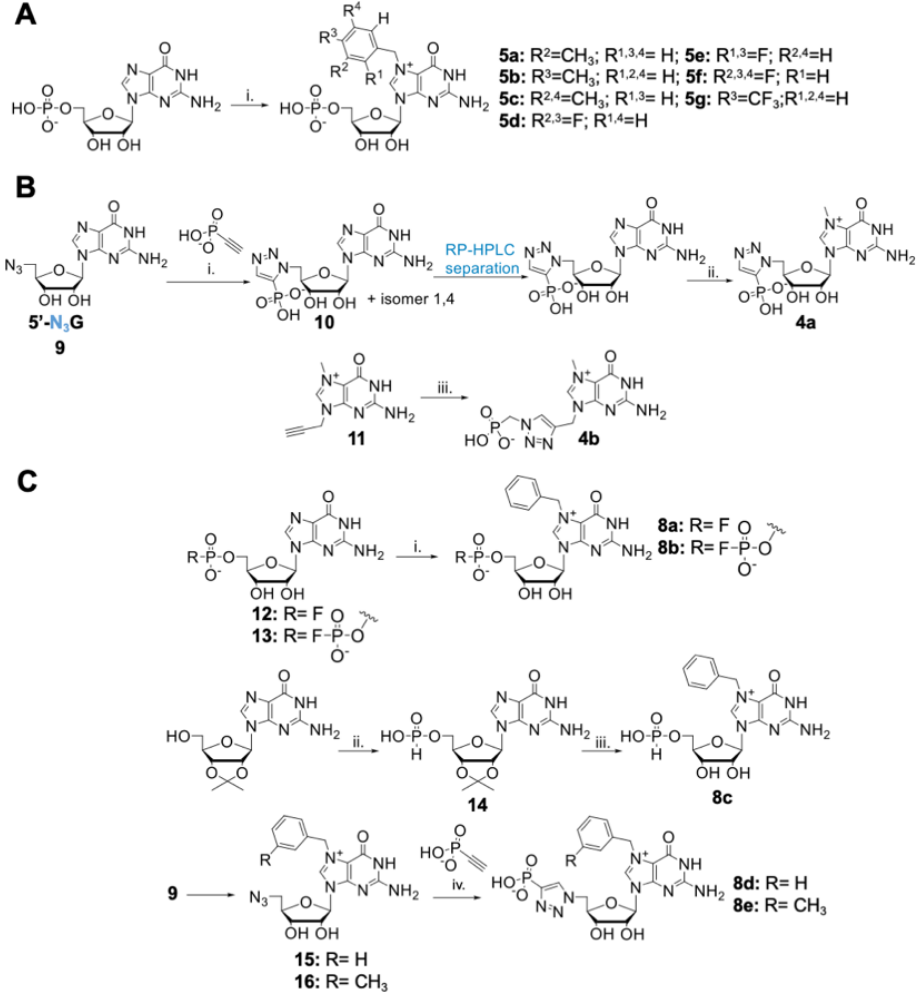
Figure 3. Synthesis of second-generation inhibitors. ( A ) Synthesis of Bn 7 GMP derivates: (i) appro ‐ priate substituted benzyl bromide; 8–10 equivalents, DMSO, 45 °C, 24 h. (B) Synthesis of triazole ‐